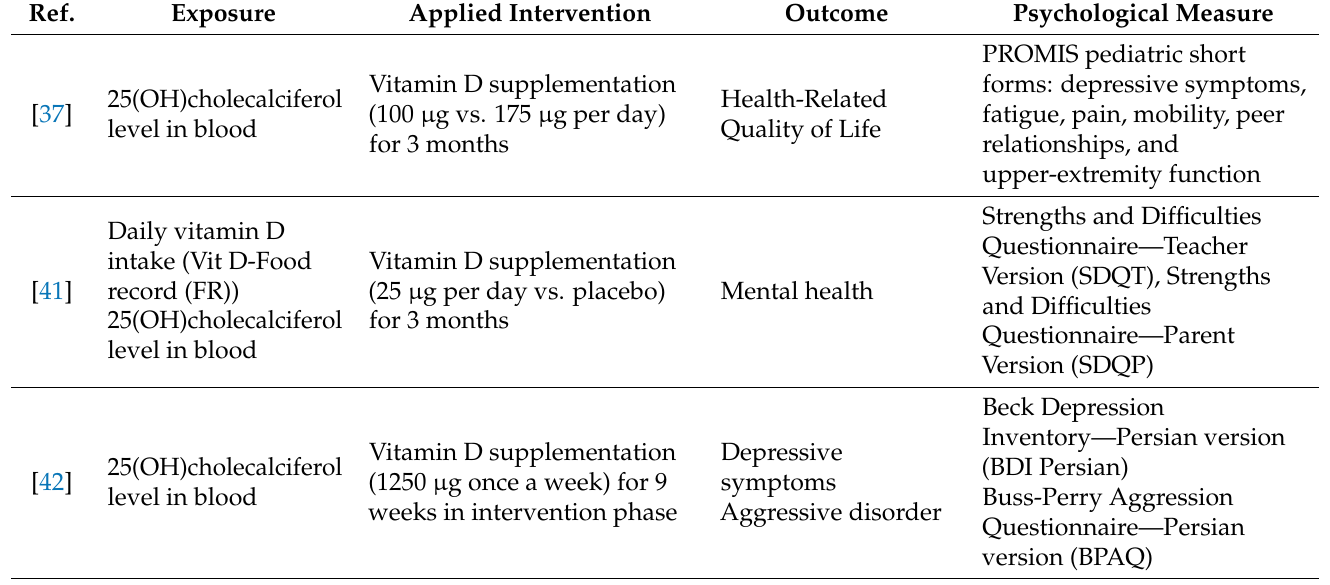
Table 4. The exposure, intervention and outcome of the included intervention